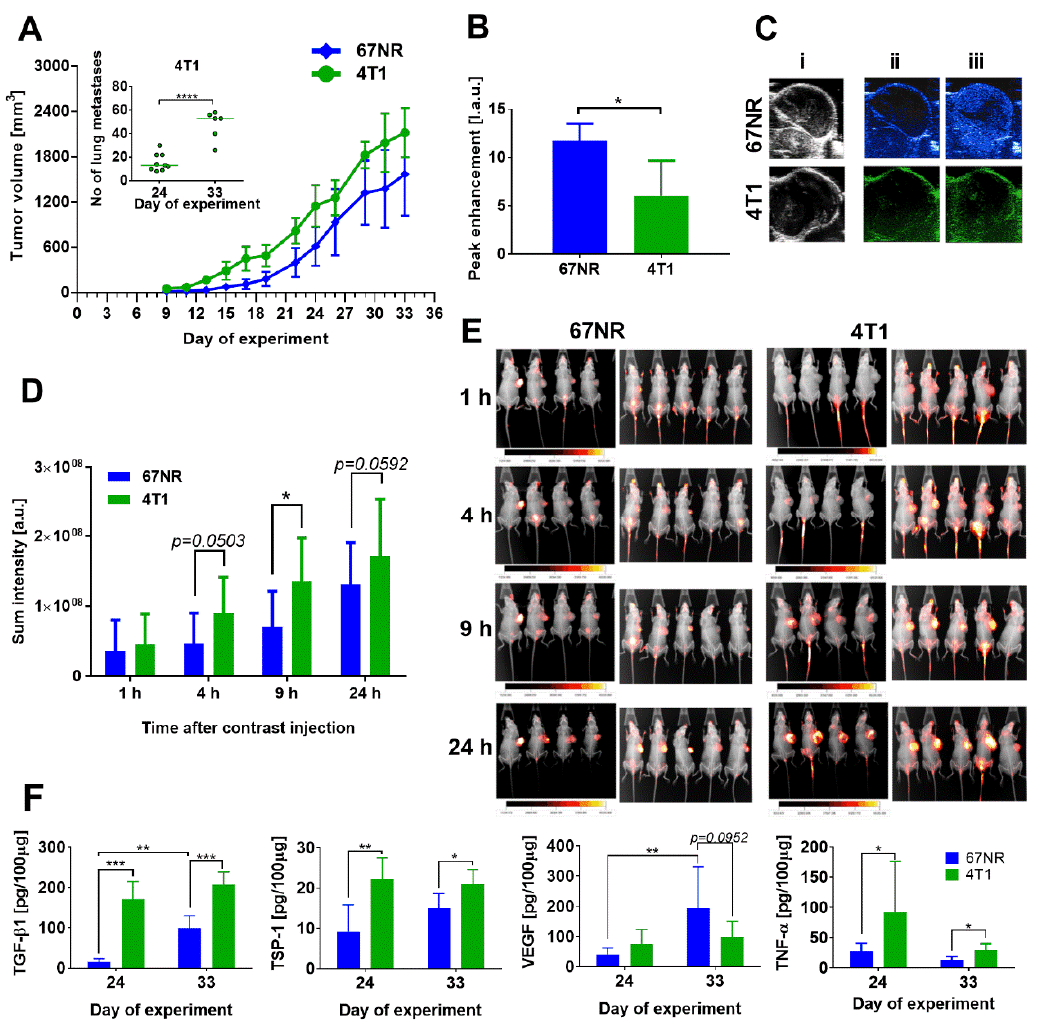
Figure 1. Basic characteristics of 67NR tumors compared to 4T1 mouse mammary gland tumors in 6- to 8-week-old mice. ( A ) Tumor growth kinetics of 67NR and 4T1 cancer and in inserted graph: number of metastases on 2 steps of 4T1 tumor progression. ( B ) Analysis of tumor blood perfusion: peak enhancement parameter. ( C ) Representative pictures of ( i ) Ultrasonography (USG) image, ( ii ) tumors before contrast agent injection, ( iii ) tumors maximally filled with the contrast agent. ( D ) Blood vessel permeability: fluorescence of IRDye ® 800CW fluorescent dye PEG Contrast Agent. ( E ) Pictures of X-ray and fluorescence images of mice. ( F ) Tumor tissue level of transforming growth factor β 1 (TGF- β 1), thrombospondin 1 (TSP-1), vascular endothelial growth factor (VEGF), and tumor necrosis factor α (TNF- α ). Data presented as mean ± SD or data for individual mice (insert in figure A ). Number of mice per group: ( A ) 6–9; ( B ) 3–4; ( D ) 9; ( F ) 5. Statistical analysis: Tukey’s multiple comparison test * p < 0.05, ** p < 0.01, *** p < 0.001, **** p < 0.0001.